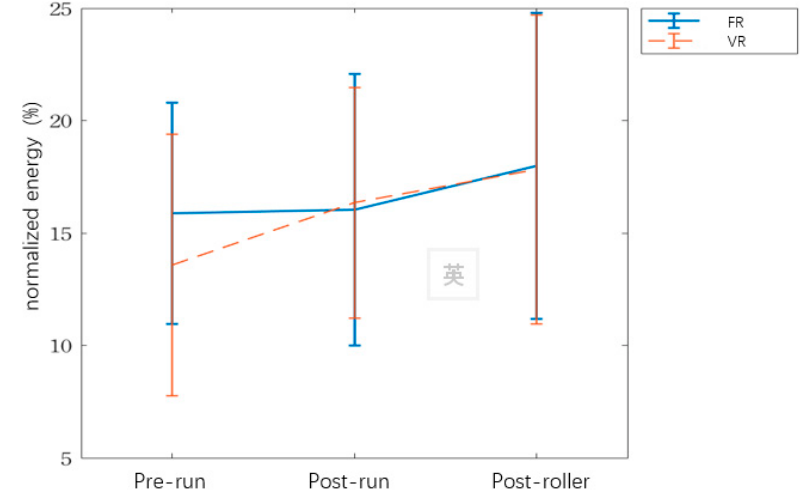
Figure 7. The trend plot of normalized energy in myogenic frequency band.